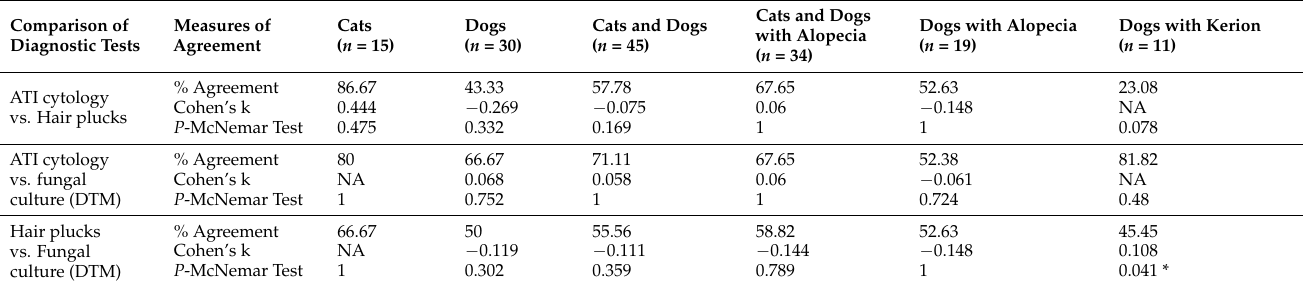
Table 6. Comparison of adhesive tape impression cytology with the other diagnostic tests using different measures of agreement (NA = Not Applicable,* corresponds to p ≤